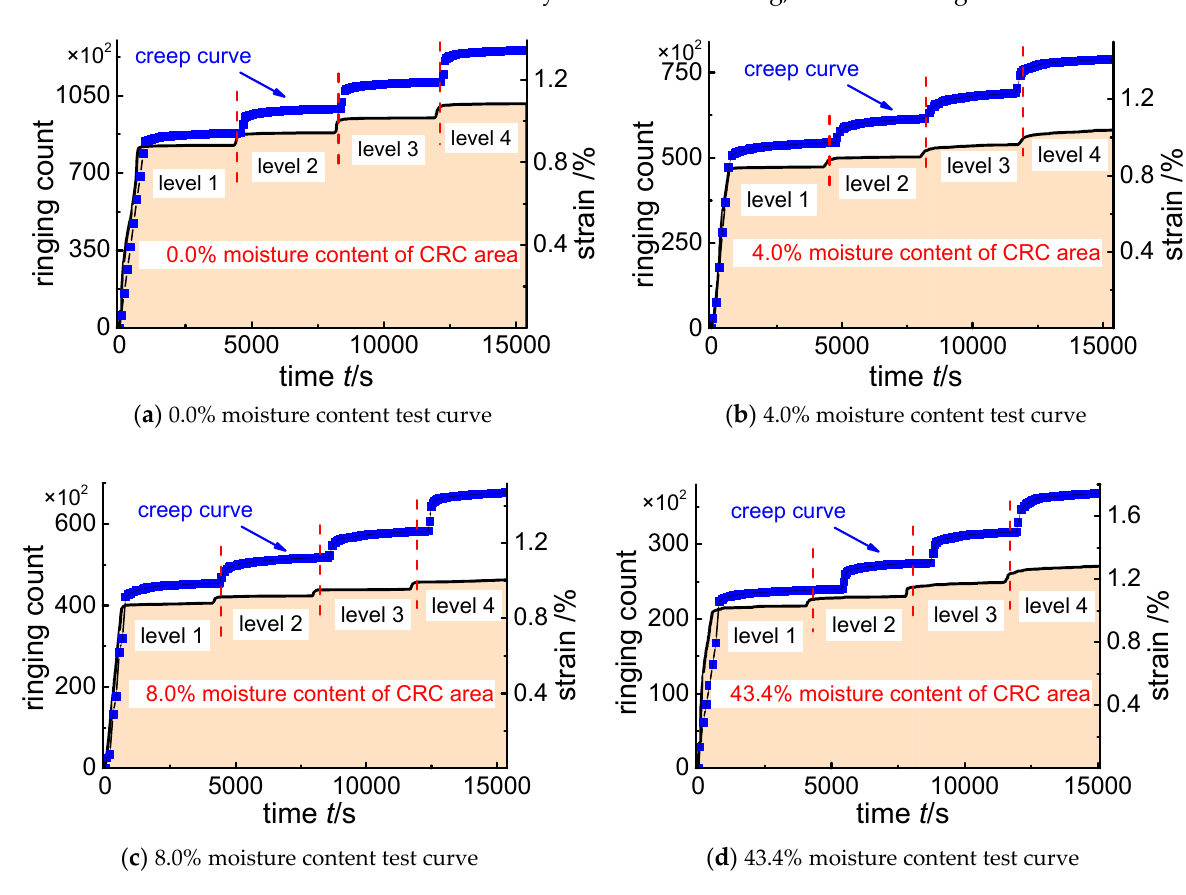
Figure 9. AE cumulative ringing count (CRC) curve (black line) and creep curve (blue line) with time.